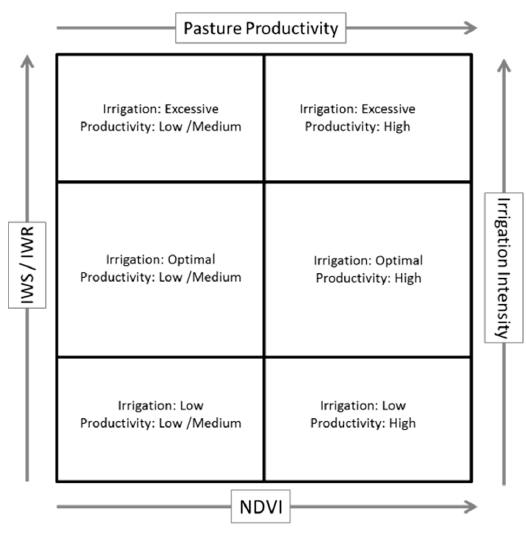
Figure 5. Diagram showing categories of total irrigation water productivity (TIWP) measure.